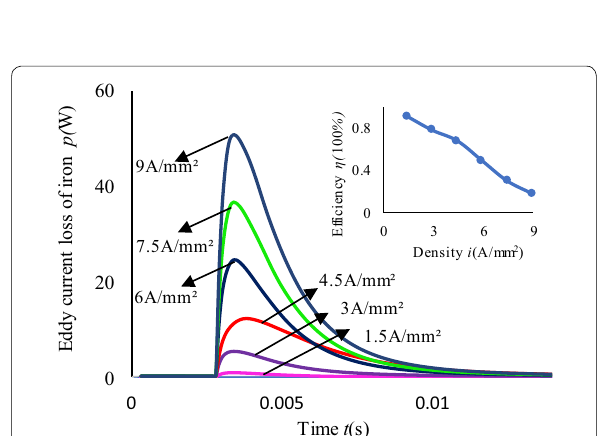
Figure 13 Electromagnetic force output by PWM driving